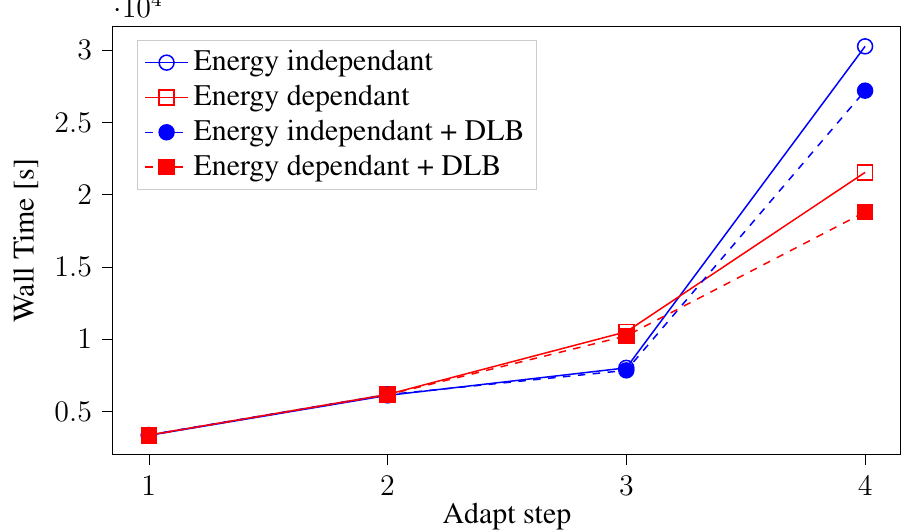
Figure 3: Comparisson of runtimes for energy dependent angular discretisation with angular adaptivity and dynamic load balancing (DLB). The energy dependent, load balanced run resulted to 38% faster